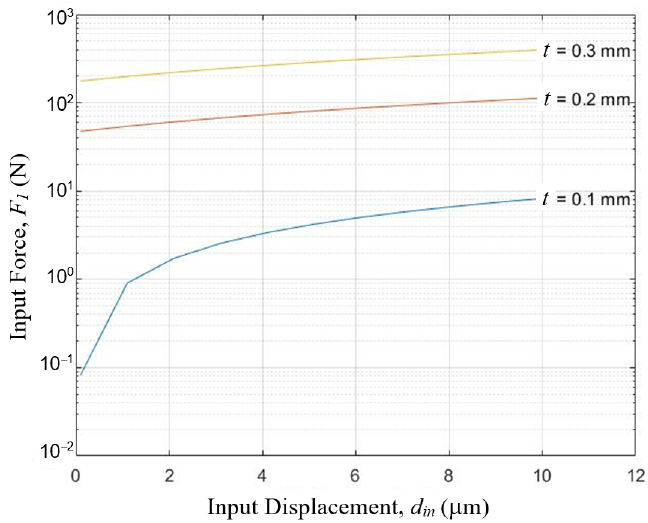
Figure 13. Relations between input force and input displacement of a three-stage cascaded lever structure at different hinge thickness t , when hinge width b = 8 mm, as computed by Equation (12) of the simplified analytical model.